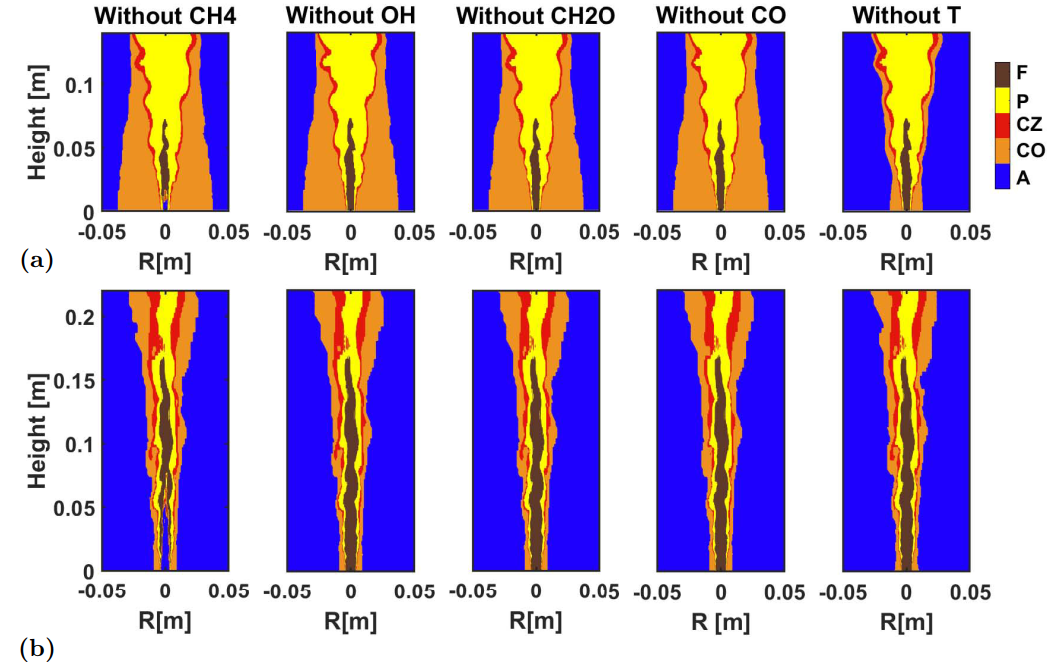
Figure 9. CRI results of BPNN with four-dimensional input: ( a ) HM1; ( b ) Sandia Flame D.